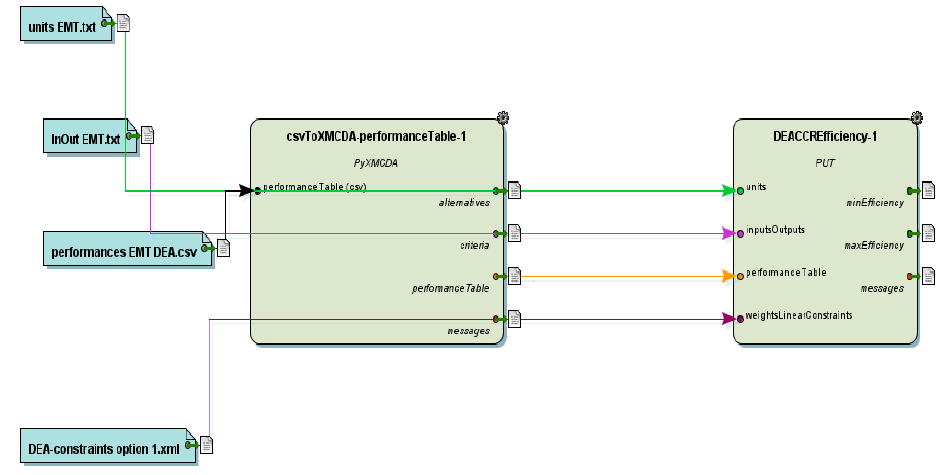
Figure 2. Diviz workflow to implement the DEA model with restrictions over the weights.